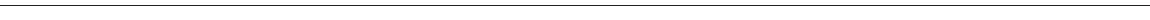
FIGURE 6 | ± SD of five mice from two separate experiments are plotted. (B) Representative flow cytometry histogram of CCR7 expression on TCR β + CD138- and TCR β + CD138 + cells are shown. Mean ± SD percentages and MFIs for CCR7 expression from six mice in two separate experiments are plotted. (C) Splenic TCR β + CD138 + and TCR β + CD138- cells were sorted from 12 weeks old MRL/Lpr mice and BCL-6 , Bim1 , and Prdm1 mRNA were quantified by Q-PCR. Mean ± SD values of five mice from two separate experiments are plotted. (D) Splenic TCR β + CD138 + and TCR β + CD138- cells were sorted from 12 weeks old MRL/Lpr mice and cultured with anti-CD3/CD28 antibodies overnight. Culture supernatant IFN γ and IL-2 levels were measured by ELISA. Mean ± SD of nine mice from three independent experiments are plotted. (E) Splenic TCR β + CD138 + , TCR β + CD138- cells were sorted from 12 weeks old MRL/Lpr mice and co-cultured with sorted B cells from the same mice in the presence of DNA for 3 days. Culture supernatant IFN γ and IL-2 levels were measured by ELISA. Mean ± SD of five mice from two separate experiments are plotted. (F) Cells were collected from spleen, lymph nodes, and bone marrows of 12 weeks old MRL/Lpr mice. Frequencies of Tcm (CD44 + CD62L + ) and Tem (CD44 + CD62L-) cells among TCR β + CD138- and TCR β + CD138 + cells were measured in flow cytometry. Mean percentages ± SD of five mice from two independent experiments are plotted. (G) Splenocytes were collected from 12 weeks old Balb/c, C57BL/6, and MRL/Lpr mice. Frequencies of Tcm (CD44 + CD62L + ) and Tem (CD44 + CD62L-) cells among TCR β + CD138- and TCR β + CD138 + cells were measured in flow cytometry. Mean percentages ± SD of five mice from two independent experiments are plotted. Two tailed Mann-Whitney rank sum test was used to calculate statistical